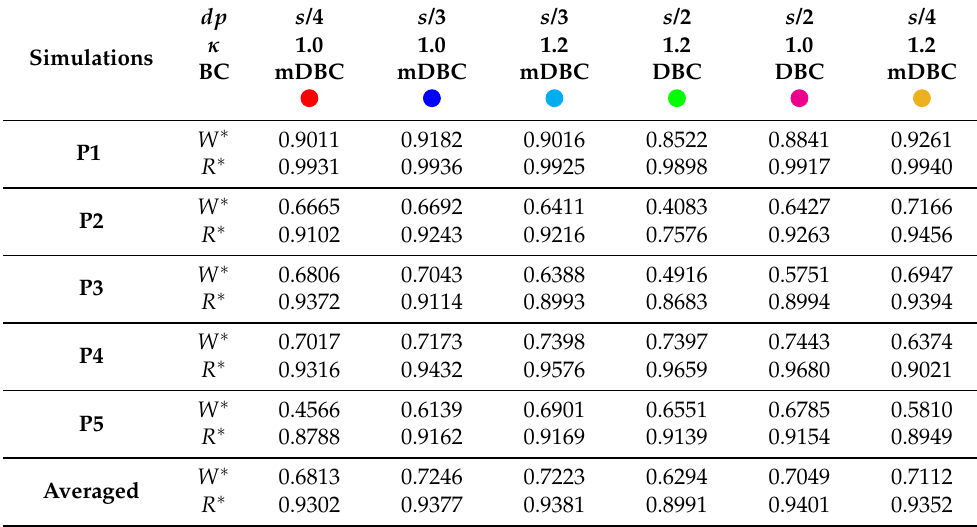
Table 4. Summary table, with index of agreement and linear correlation error for each point and each